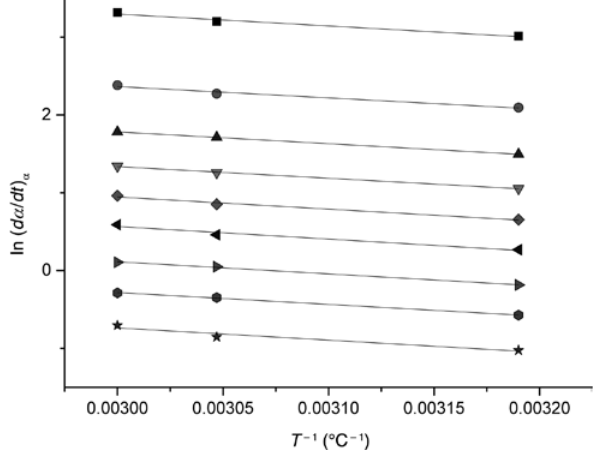
Figure 3: The dependences of ln d α / dt on T − 1 for different degrees of caffeine extraction at [0.1 ( ), 0.2 ( ), 0.3 ( ), 0.4 ( ), 0.5 ( ),